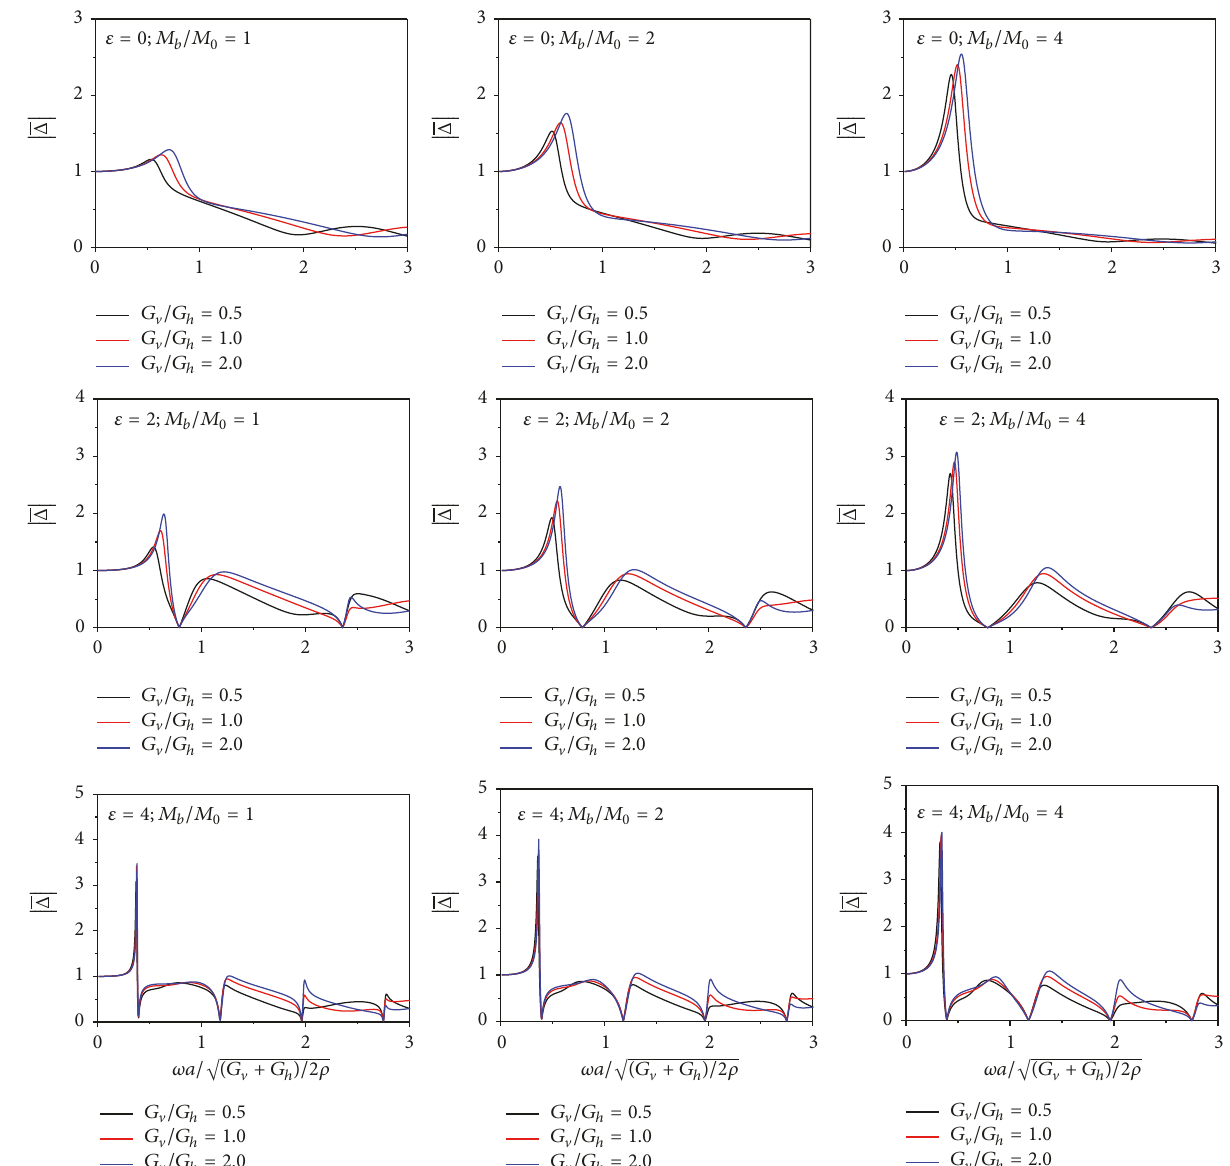
Figure 4: The effective input motion for different flexibility and mass of superstructure and for 𝐷/𝑎 = 2